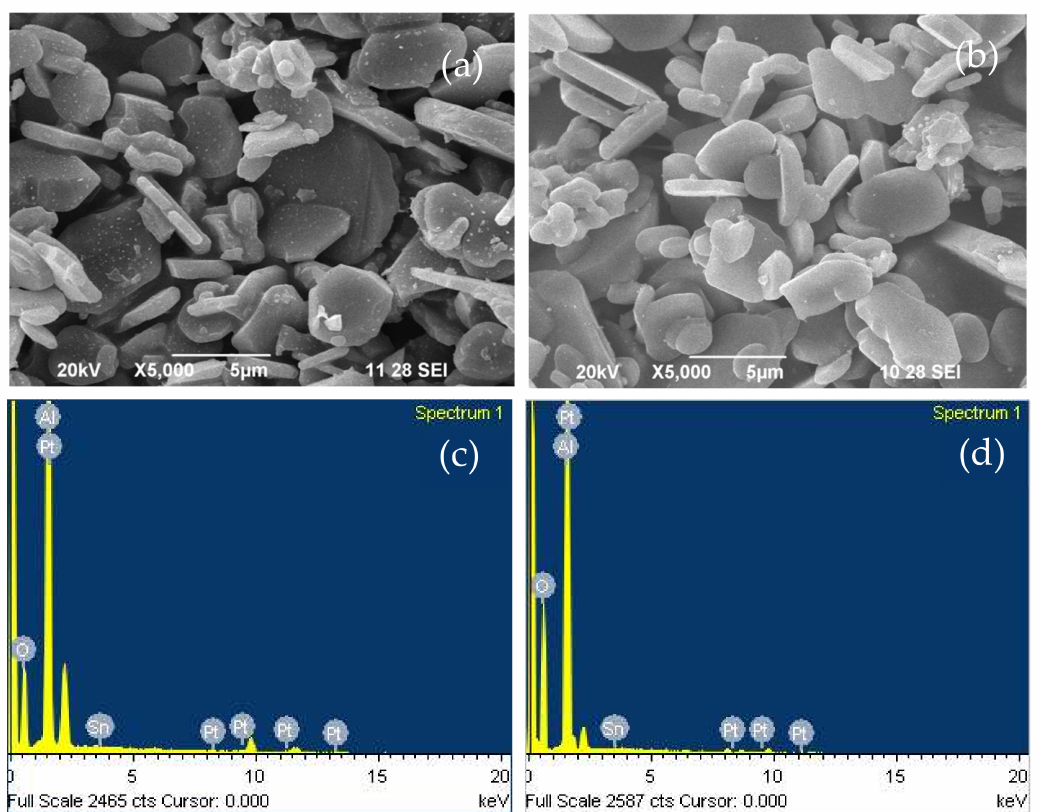
Figure 3. Scanning electron microscopy (SEM) morphology of Pt–Sn / Al 2 O 3 reduced with ( a ) NaBH 4 and ( b ) H 2 , and energy dispersive X-ray spectroscopy (EDS) mapping of Pt–Sn / Al 2 O 3 reduced with ( c ) NaBH 4 and ( d ) H 2